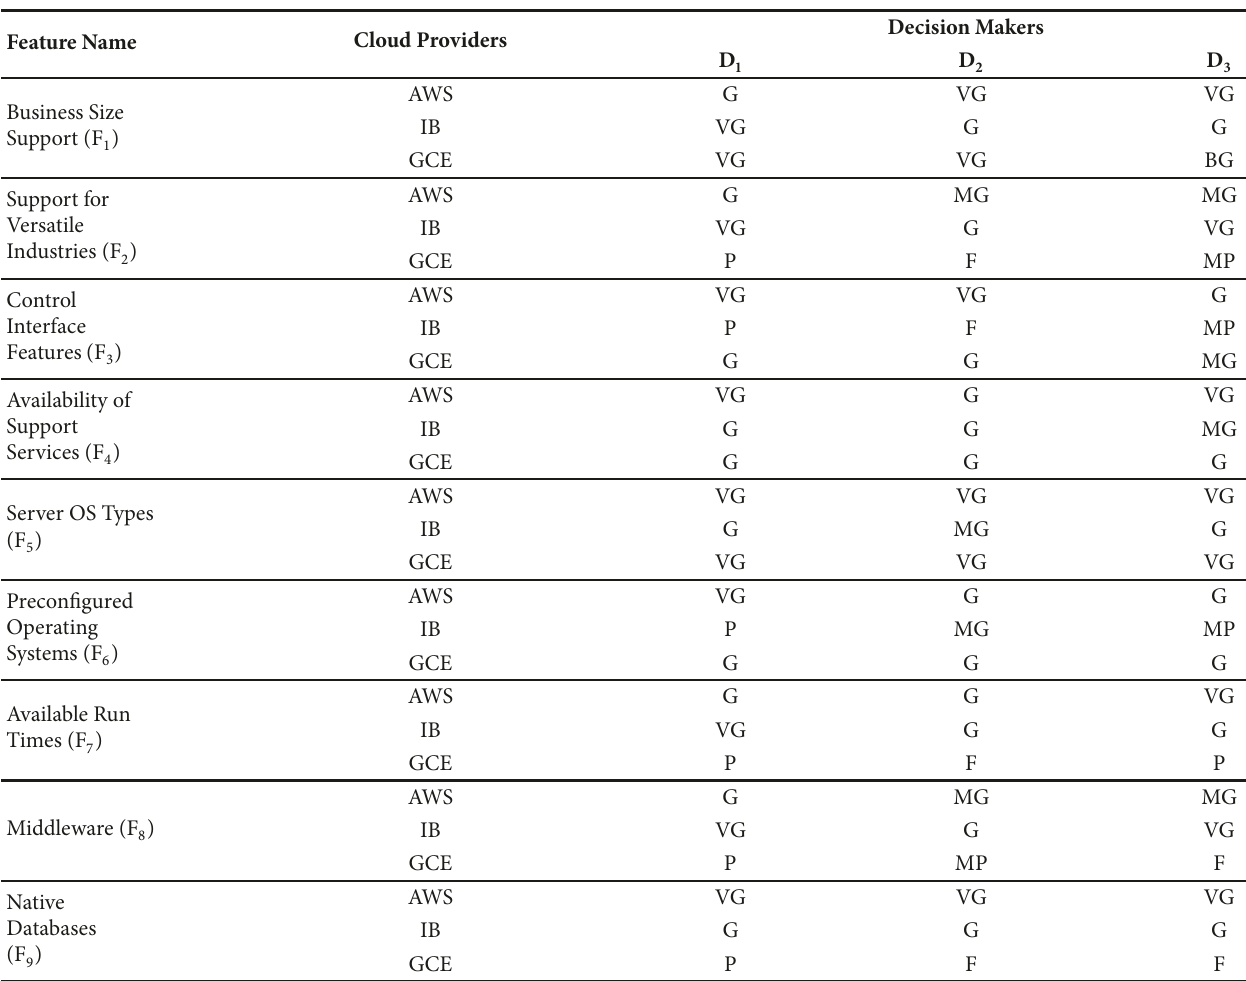
Table 3: Cloud service provider features and decision makers analysis.